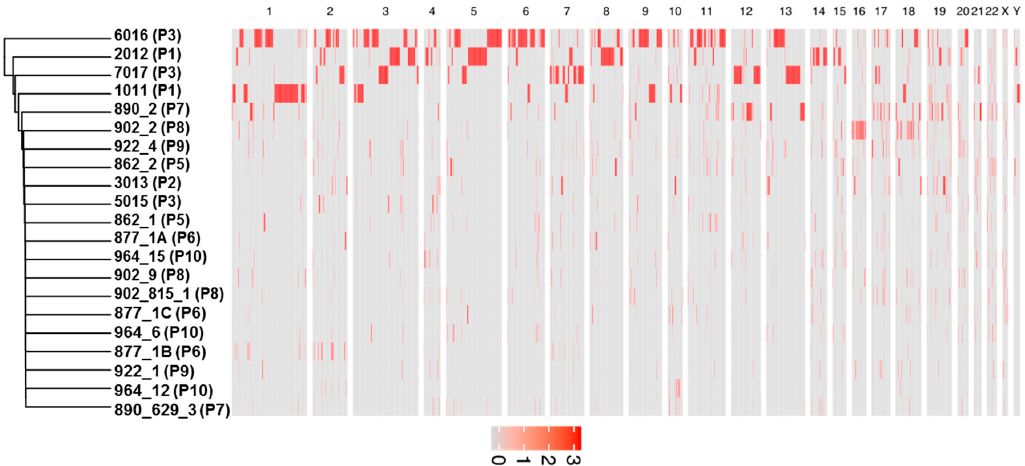
Figure 7. Heatmap showing significant large-scale amplification events in CTCs per whole chromosome. In this heat map, the chromosome number are arranged from left top to right, and 21 CTCs analysed flow vertical, top to bottom. Significant genomic amplifications are represented in red and the red intensity can vary according to the number of copies amplified. P = patient.